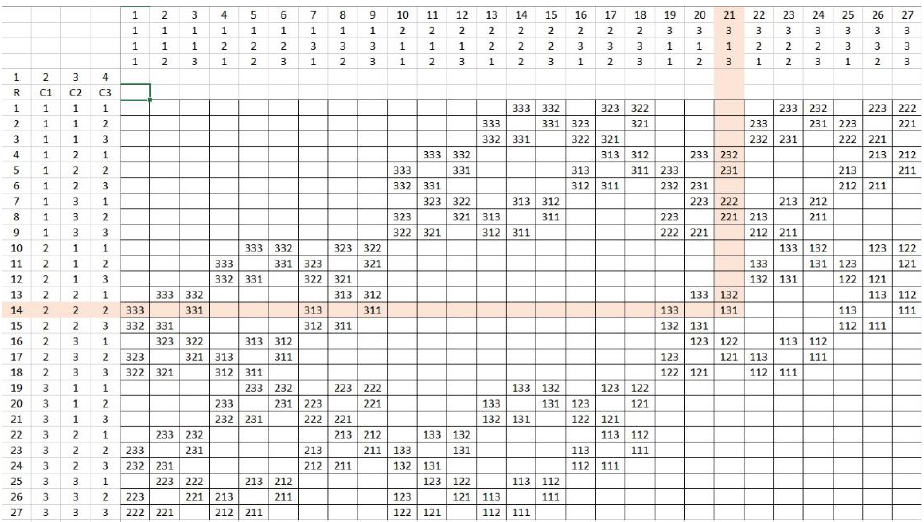
Figure 11. Accommodation of the combinations of rows of 3 × 3 matrices.